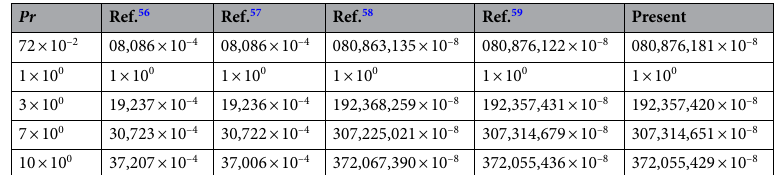
0 , 0 , ϒ 0 , M 0 , N 0 , (cid:31) r = = = =